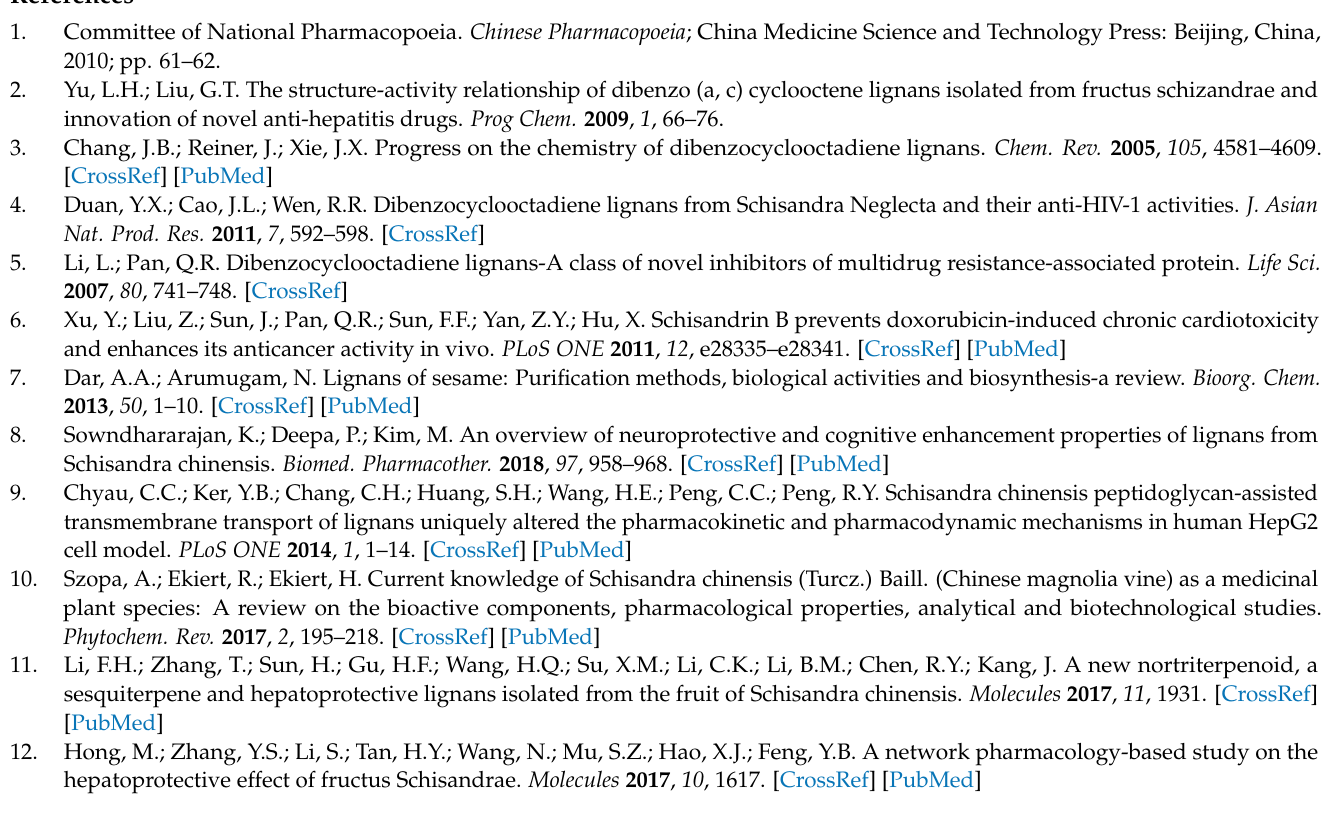
Supplementary Materials: The following are available online. The 1 H NMR and 13 C NMR spectral fruit. Table S1: The data of single factor experiments, Table S2: The factors and levels table of L 9 (3 4 ) orthogonal experiment, Table S3: The orthogonal experiment table, Table S4: The results of orthogonal test, Table S5: The analysis of variance for orthogonal